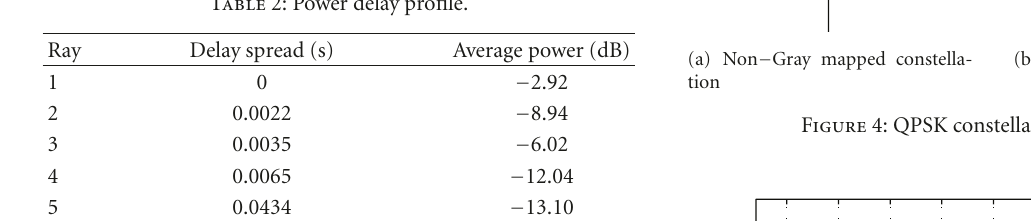
Table 2: Power delay profile.